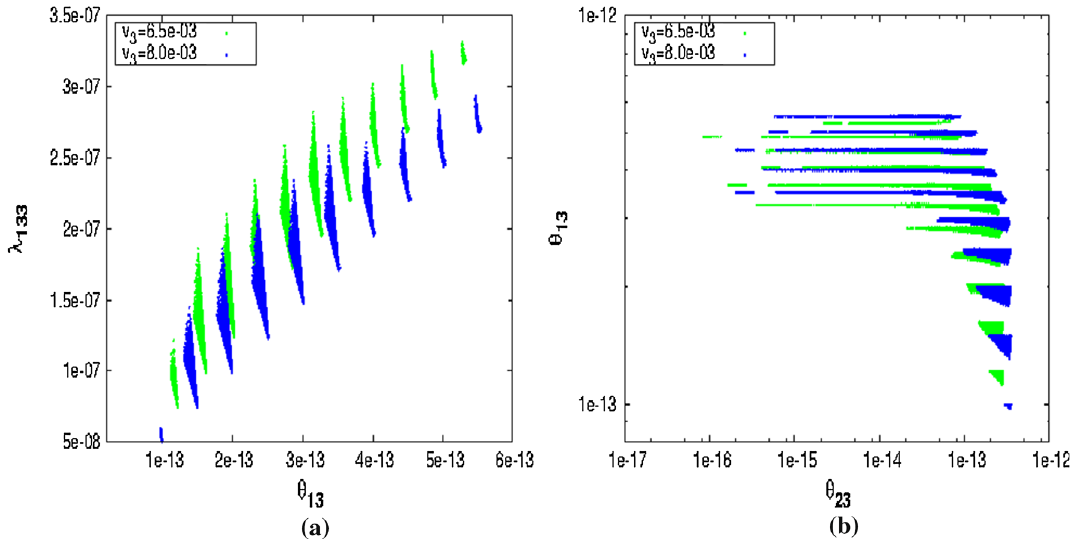
Fig. 3 The available model parameter space in the θ 13 – λ 133 plane is shown in the left panel (Fig. 3a), while in the right panel (Fig. 3b) the same region is depicted when θ 23 is varied against θ